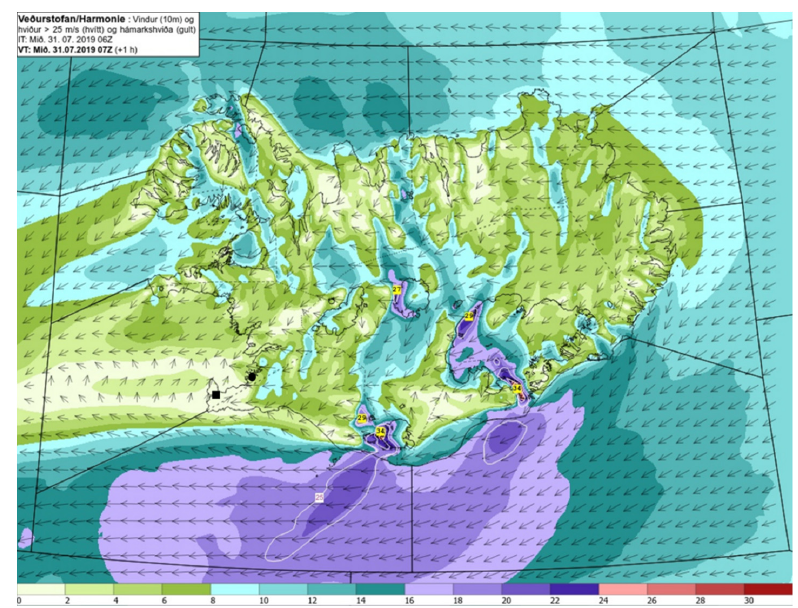
Figure 10. Wind conditions of the July case. The HARMONIE-AROME model forecast of 10 m wind at 07:00 UTC, 31 July, 2019. The arrows indicate the wind direction while the colours indicate wind speed [m s − 1 ]. The black dot and square indicate the locations of RVK and KEF, respectively.